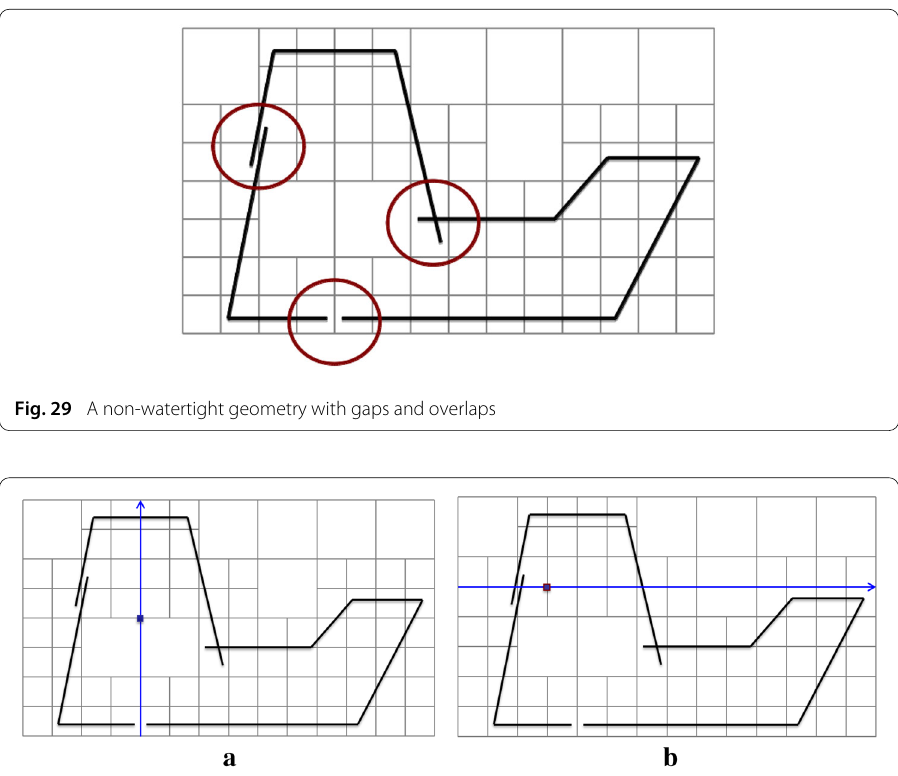
2. The ray passes through an overlapped part (see Fig. 30b). In this situation, the